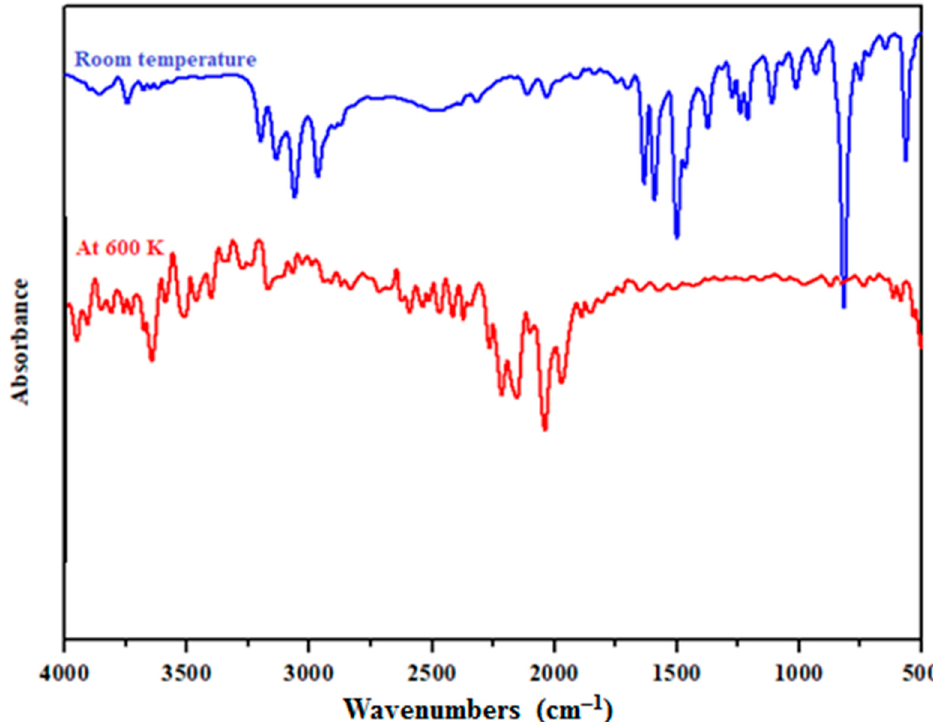
Figure 11. The FT–IR absorption spectra of compound ( I ) at 470 K and 600 K.